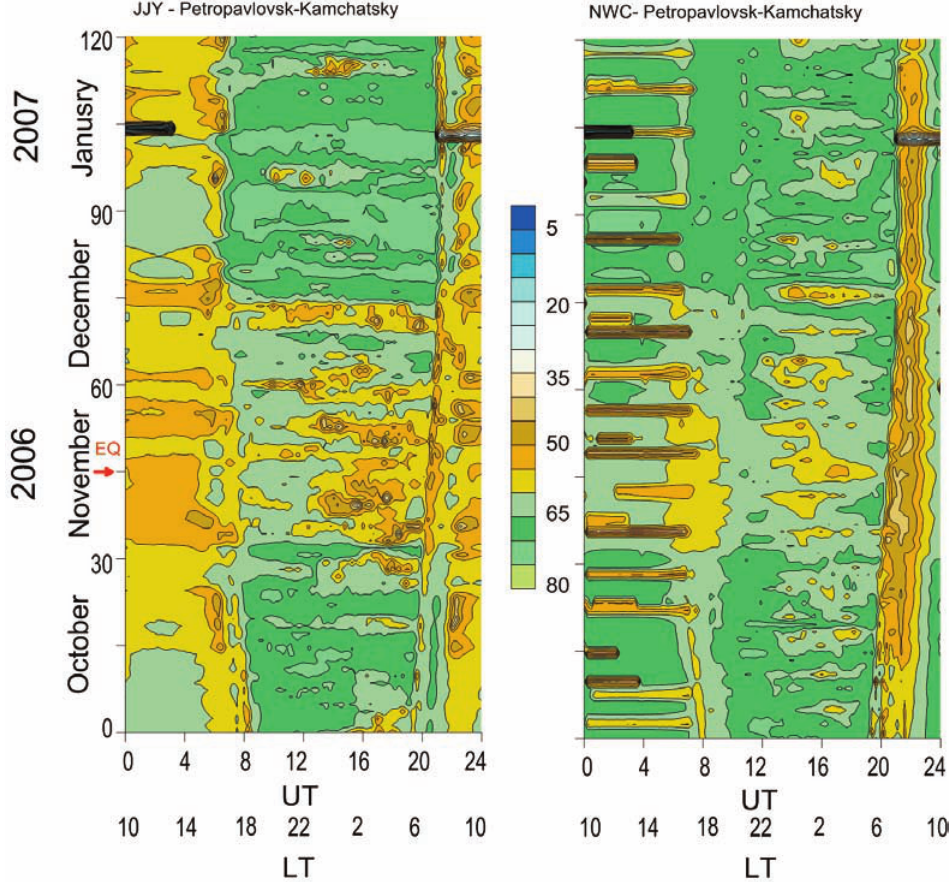
Figure 2. Contour map of the diurnal variations of the VLF/LF signal amplitudes at Petropavlovsk-Kamchatsky from October 1, 2006, to January 31, 2007. Left panel: Wave path JJY (40 kHz)-Petropavlovsk-Kamchatsky. Right panel: Wave path NWC (19.8